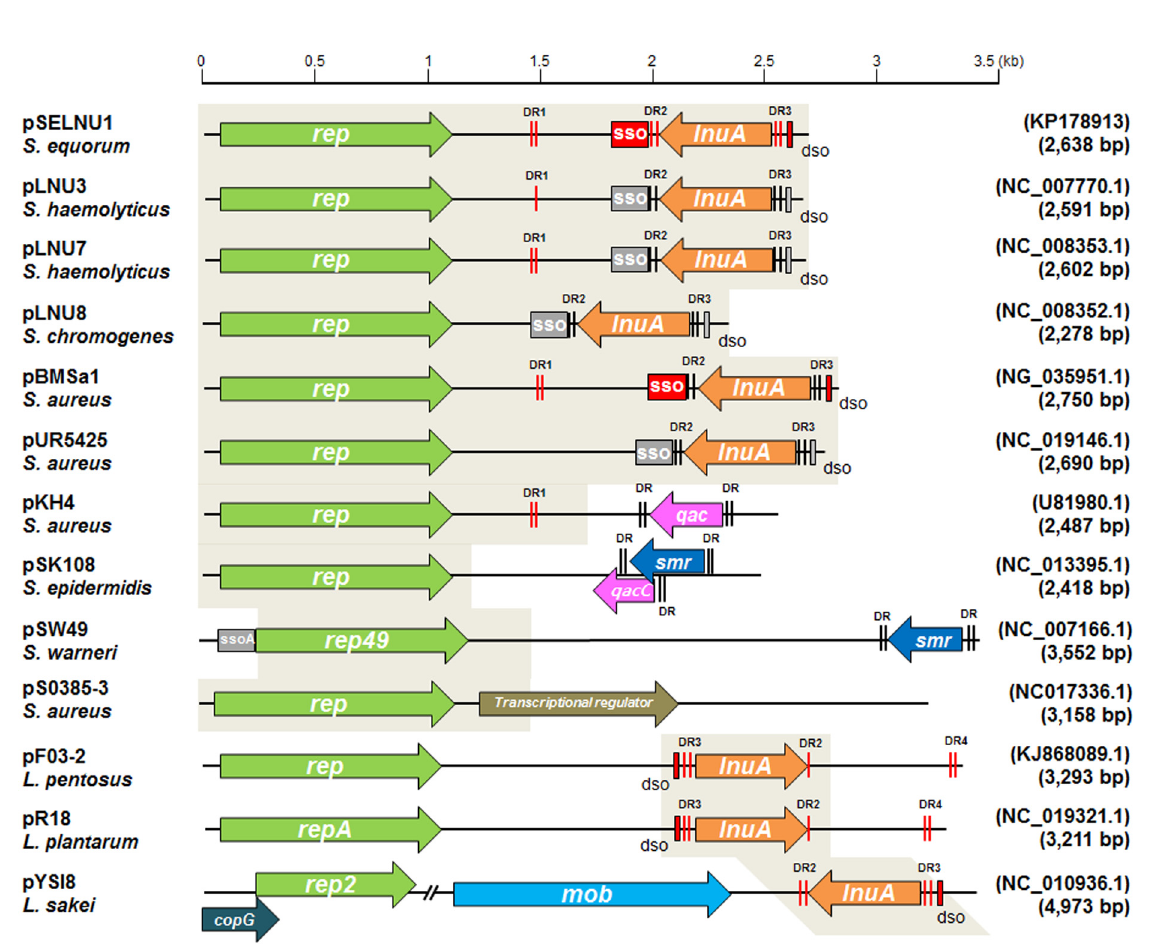
Fig 2. Small plasmid structures, rep and antibiotic/stress resistance genes. Shaded boxed regions possess over 80% nucleotide sequence identity with pSELNU1. Dso and sso regions are shown as color boxes and direct repeat sequences are indicated with vertical lines. All sequences identified in this study are indicated with